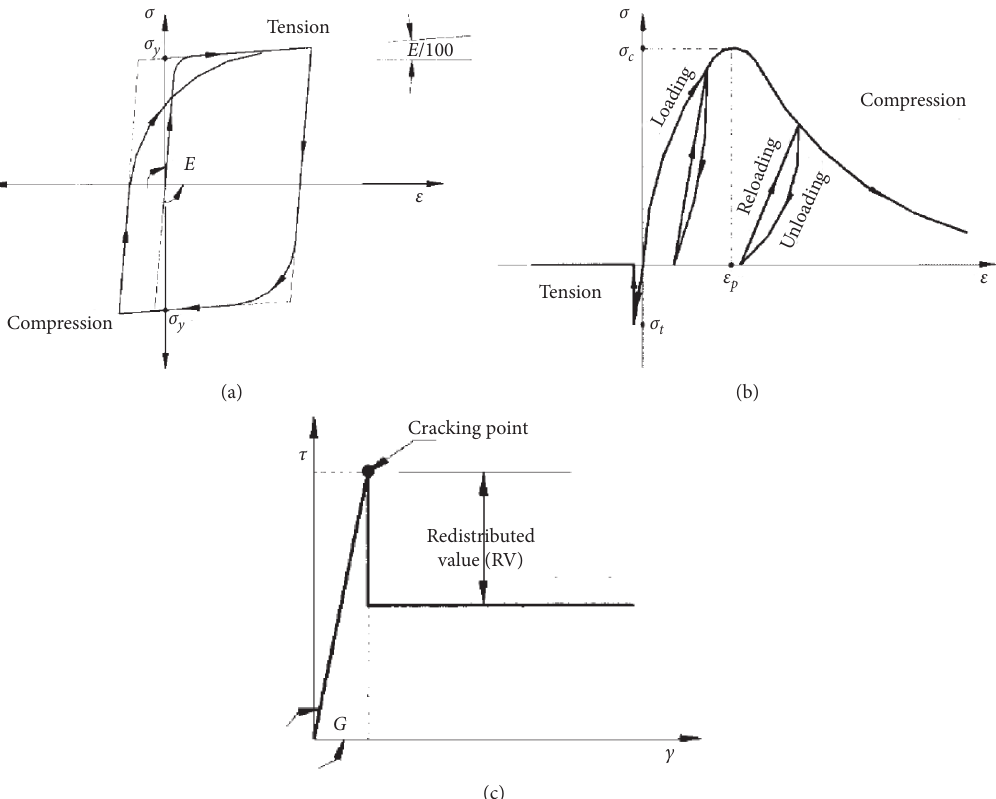
Figure 2: The constitutive models for (a) concrete under axial stress [19], (b) steel reinforcement bar under axial stress [20], and (c) concrete under shear